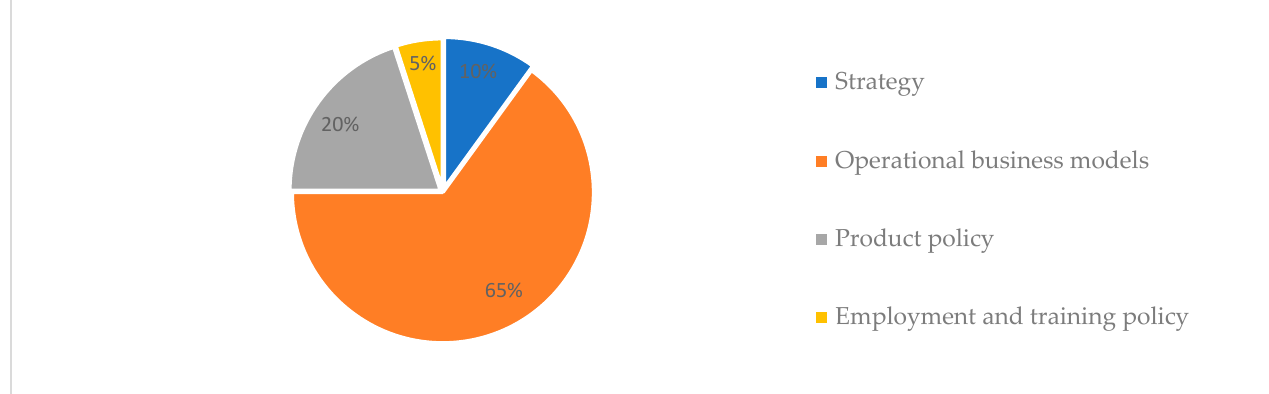
Figure 6. Which area of bank operation will be most impacted as a result of new technologies?